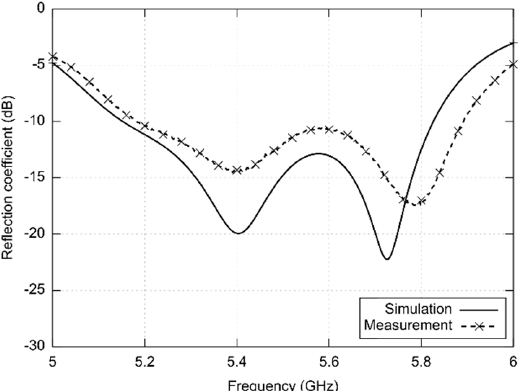
Figure 2. Simulated and measured frequency responses of reflection coefficient at the input of the antenna designed for the 5.8 GHz ISM band.